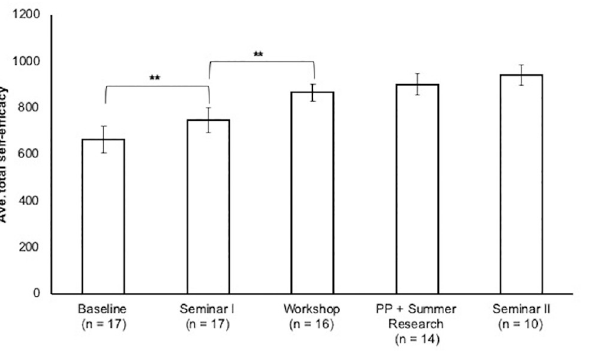
Fig 2. Average self-efficacy scores (and standard errors) after DIVAS pipeline interventions for the three years of the project. PP = pair programming. A paired t-test was used to compare means between subsequent interventions. �� , p < 0.01.